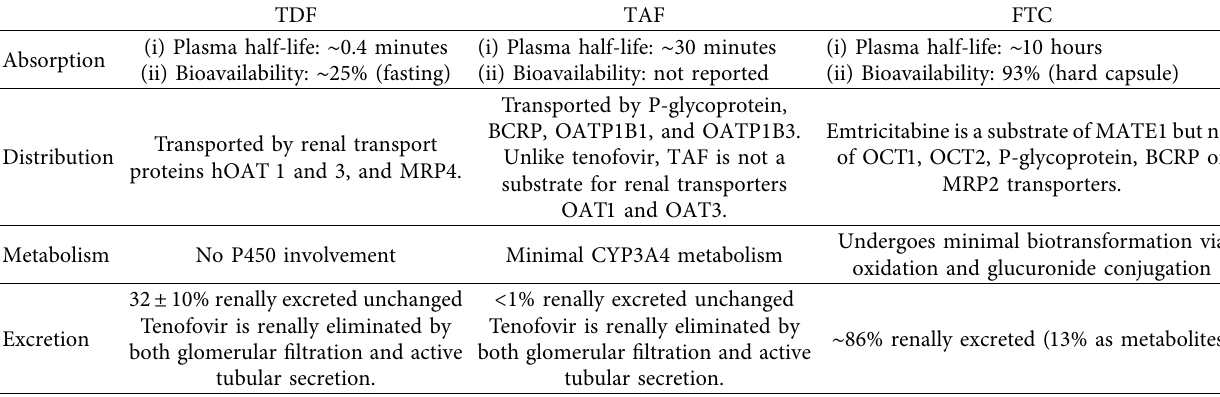
Table 4: Pharmacokinetics parameters of TDF, TAF, and FTC.